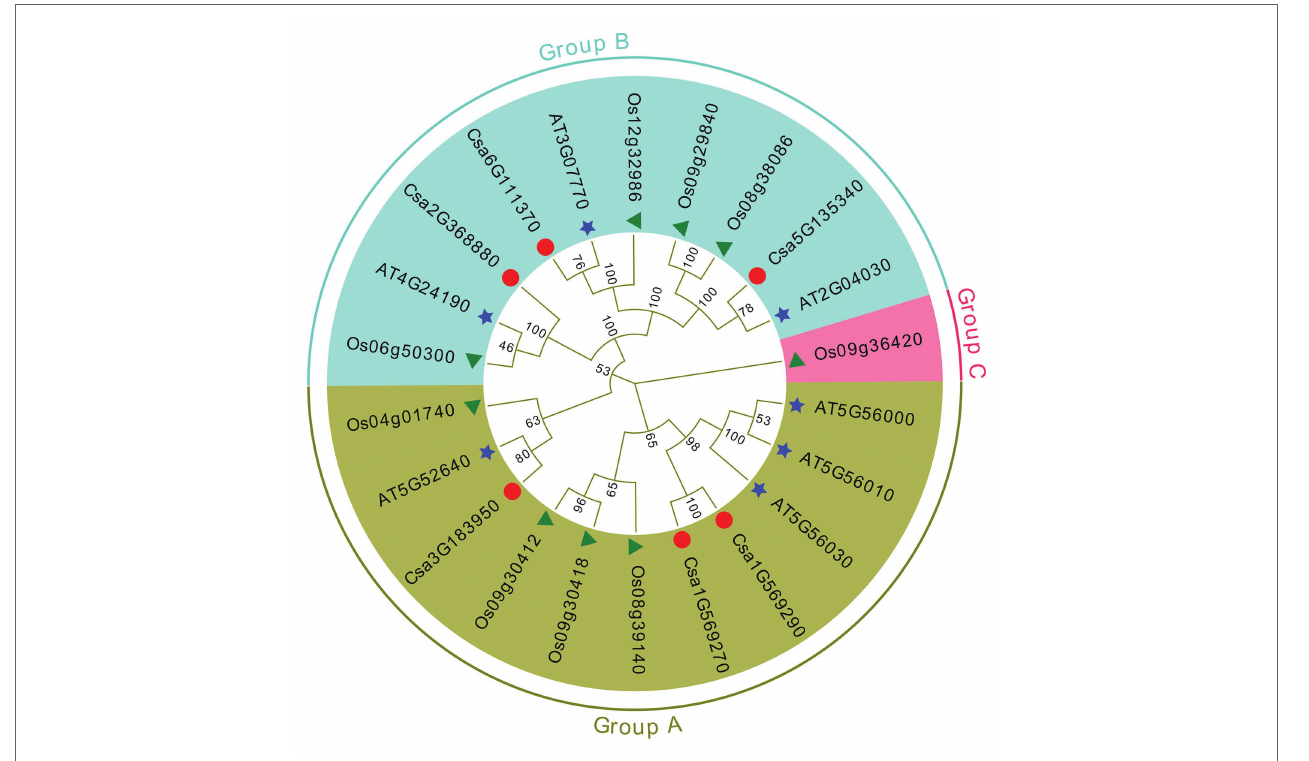
FIGURE 1 | Phylogenetic analysis of HSP90 proteins from cucumber, Arabidopsis , and